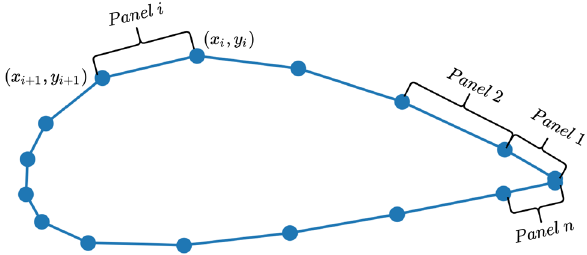
Figure 10. Panel distribution over the airfoil